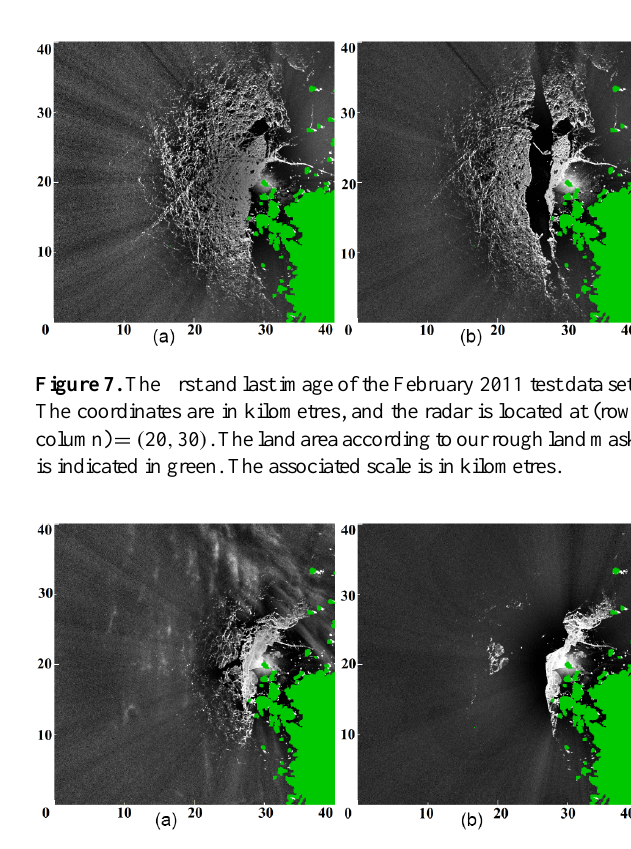
Figure 8. The first and last image of the February 2012 test data set. The coordinates are in kilometres, and the radar is located at (row, column) = ( 20 , 30 ) . The land area according to our rough land mask is indicated in green. The associated scale is in